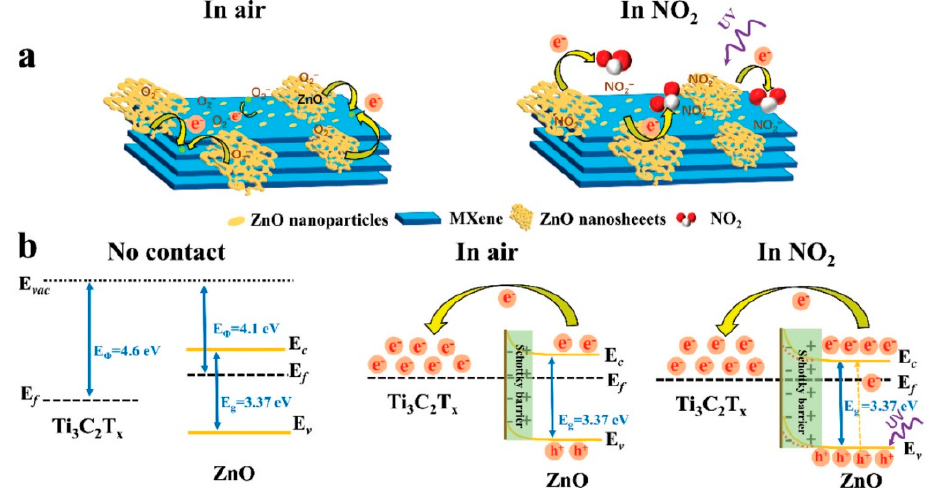
Figure 21. ( a ) Schematic diagram of the possible gas-sensing mechanism of Ti 3 C 2 T x /ZnO NS. ( b ) Energy band structure diagram of Ti 3 C 2 T x /ZnO NS Schottky barriers in air and NO 2 . Reprinted with permission from [123]. Copyright 2022: The Royal Society of Chemistry.